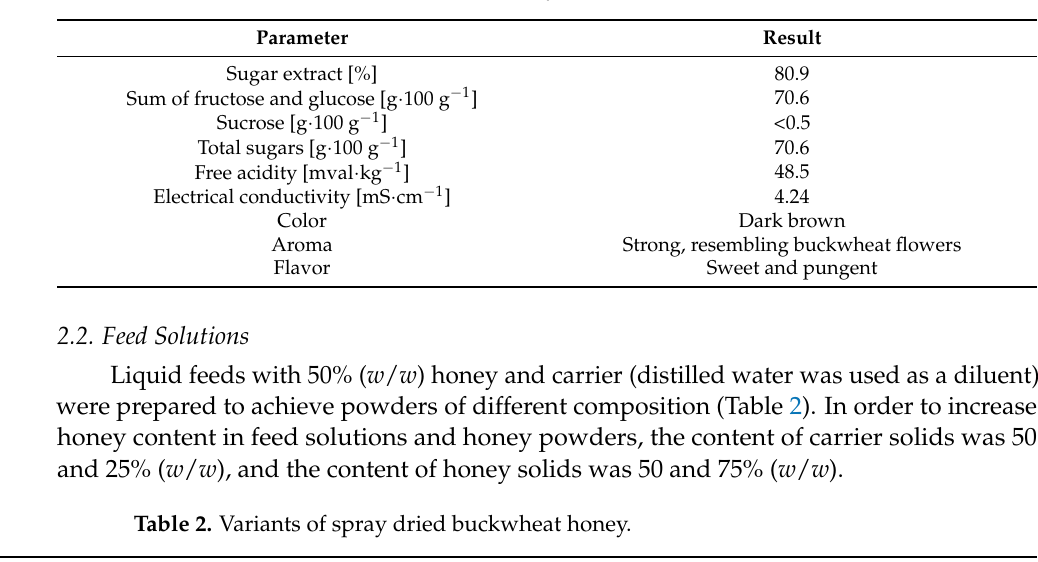
Table 1. Characterization of raw buckwheat honey.